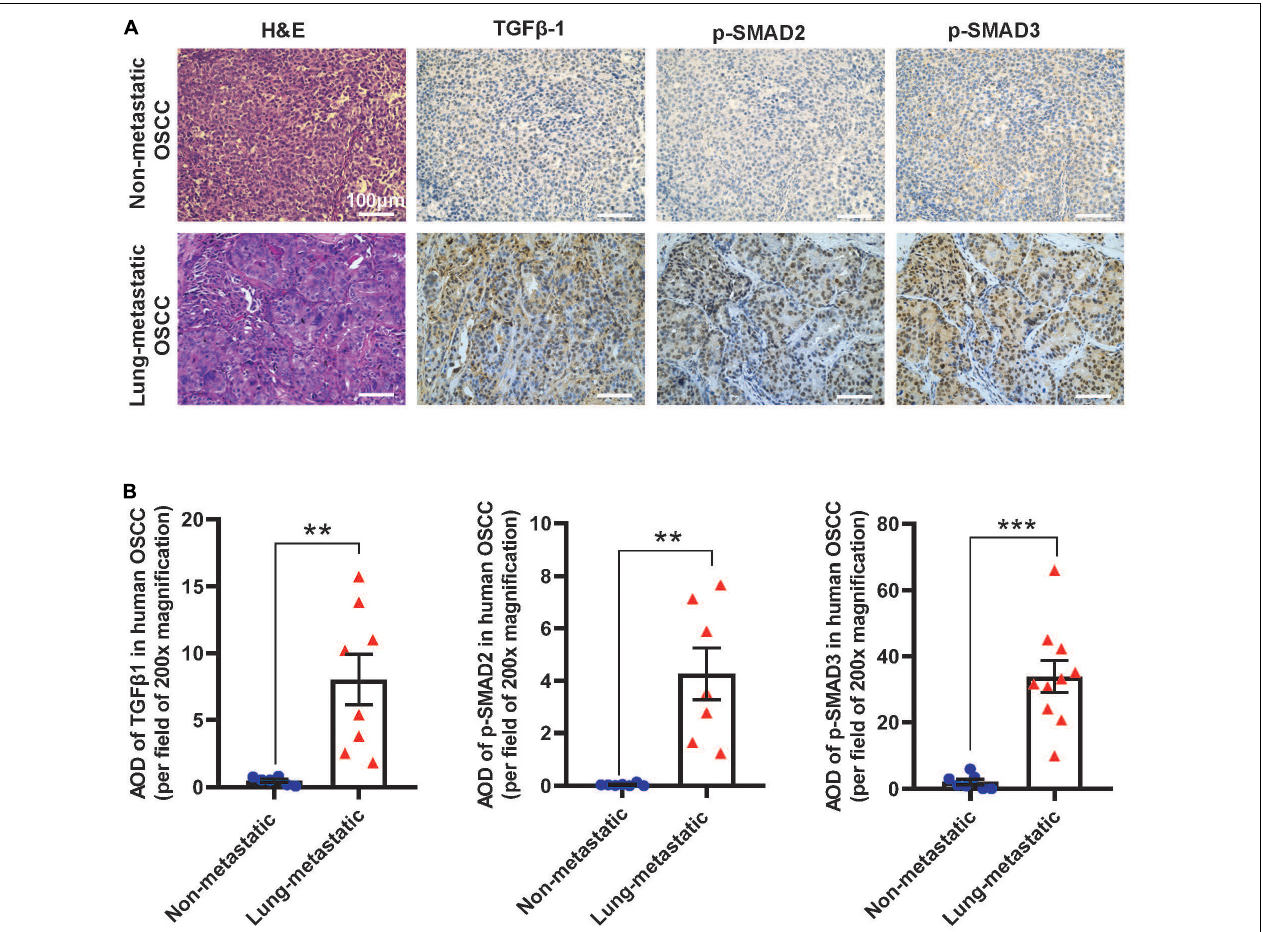
FIGURE 7 | TGF β signaling is activated in primary human OSCC tumors in patients with lung metastasis. (A) Representative H&E and IHC images examining expression of the indicated markers in human OSCC. Upper panels are staining of the primary tumor of a representative patient without metastasis and lower panels are staining of the primary tumor from a representative patient with metastasis. Scale bar: 100 µ m. (B) Quantification of TGF β 1, p-SMAD2, and p-SMAD3 staining by AOD value. ** P < 0.01, *** P <